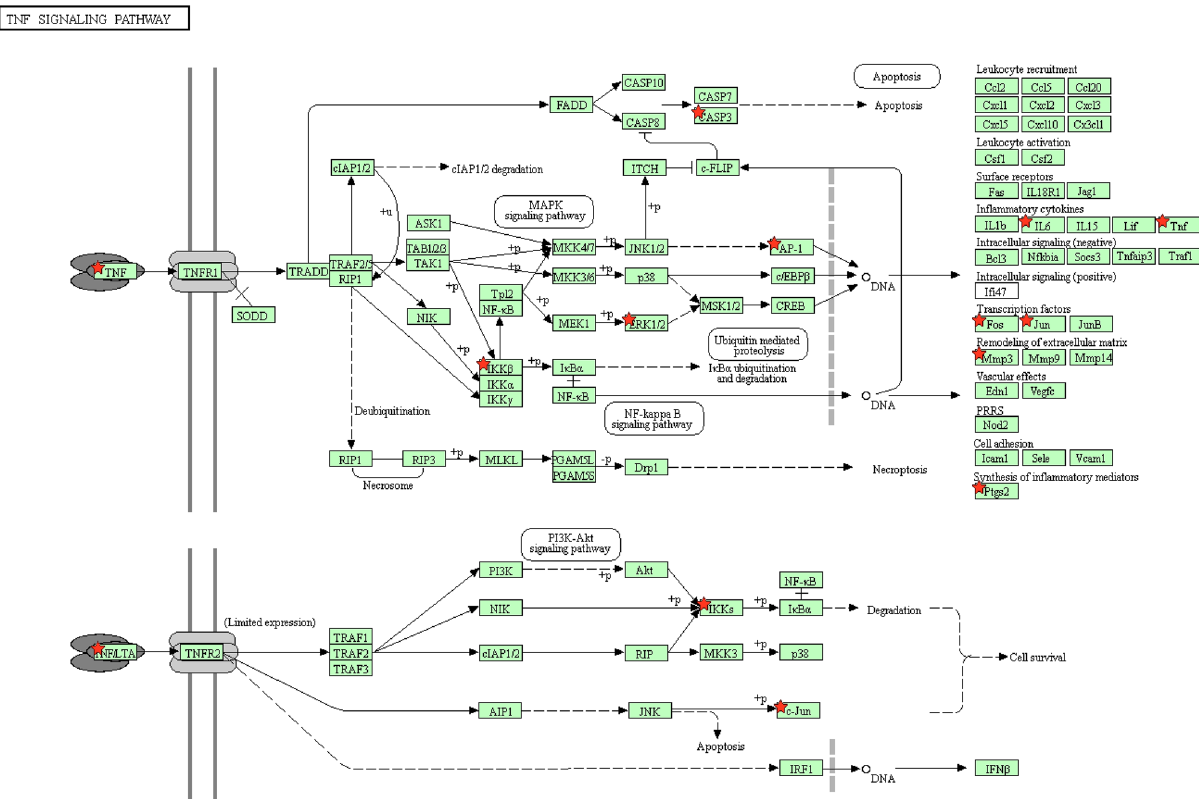
Figure 6. Distribution of the targets of Fuzi on the compressed TNF signaling pathway. The nodes with red star correspond to the targets of Fuzi, and the light blue nodes are targets in TNF signaling pathway. The compressed pathway was obtained from KEGG.